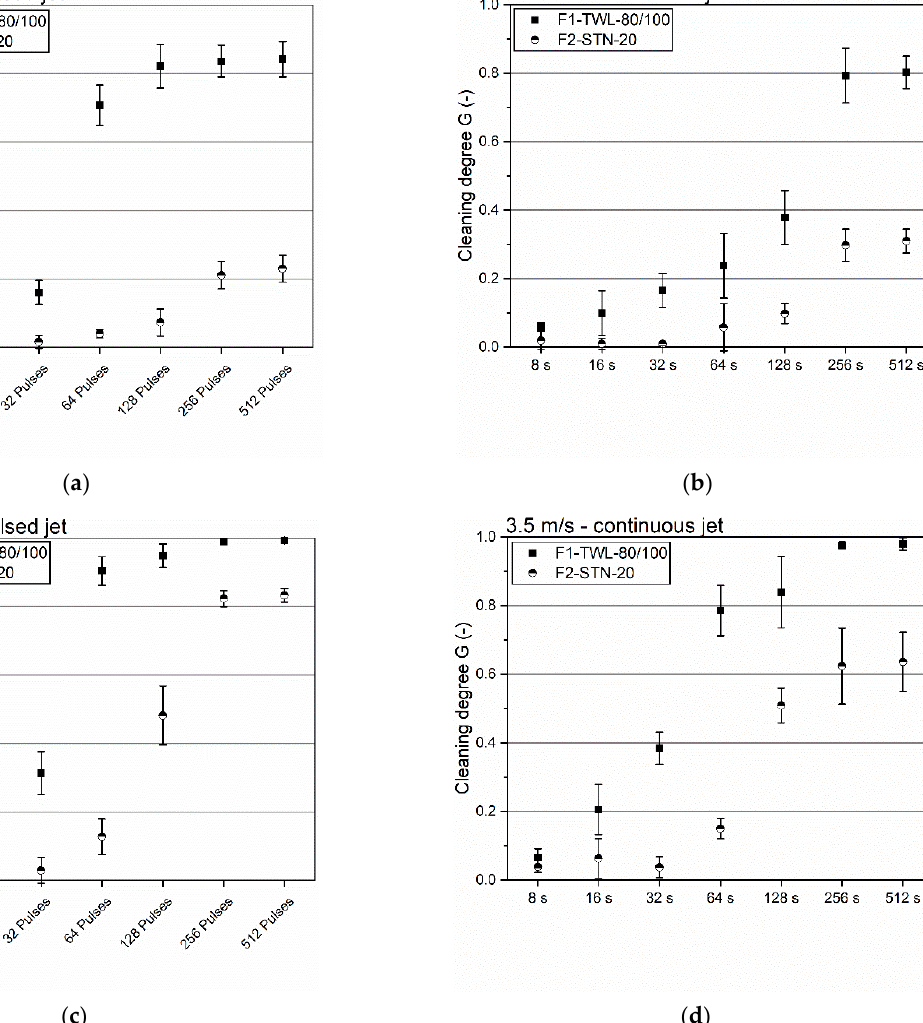
Figure 7. Comparison of both filter cloths using pulsed and continuous cleaning. ( a ) Pulsed cleaning at an inflow velocity of 1.5 m/s. ( b ) Continuous cleaning at an inflow velocity of 1.5 m/s. ( c ) Pulsed cleaning at an inflow velocity of 3.5 m/s. ( d ) Continuous cleaning at an inflow velocity of 3.5 m/s. n ≥ 5. Confidence intervals with α = 0.05. A difference between both filters was visible in all diagrams. The abrupt increase in